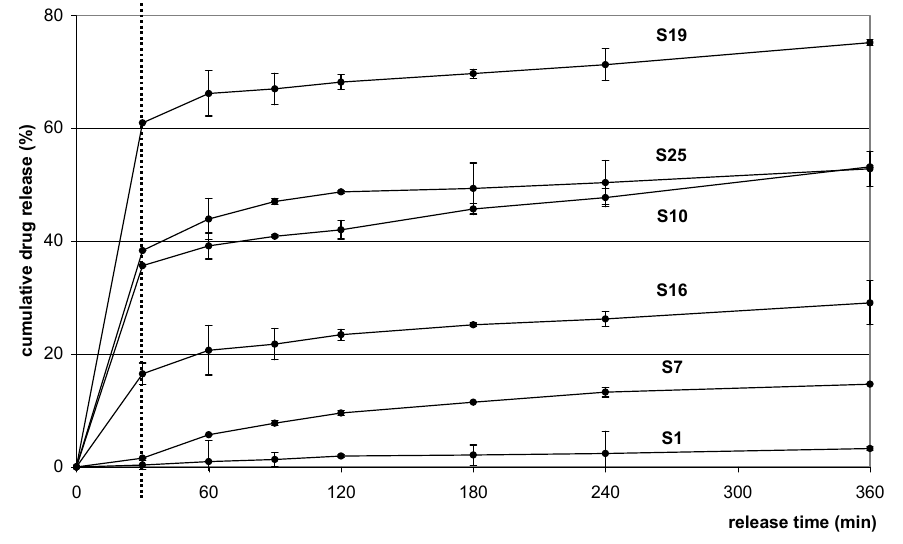
) and concentration (factor X 1